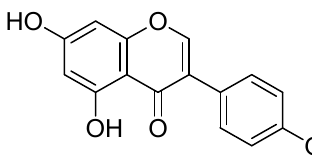
Figure 11. Genistein.